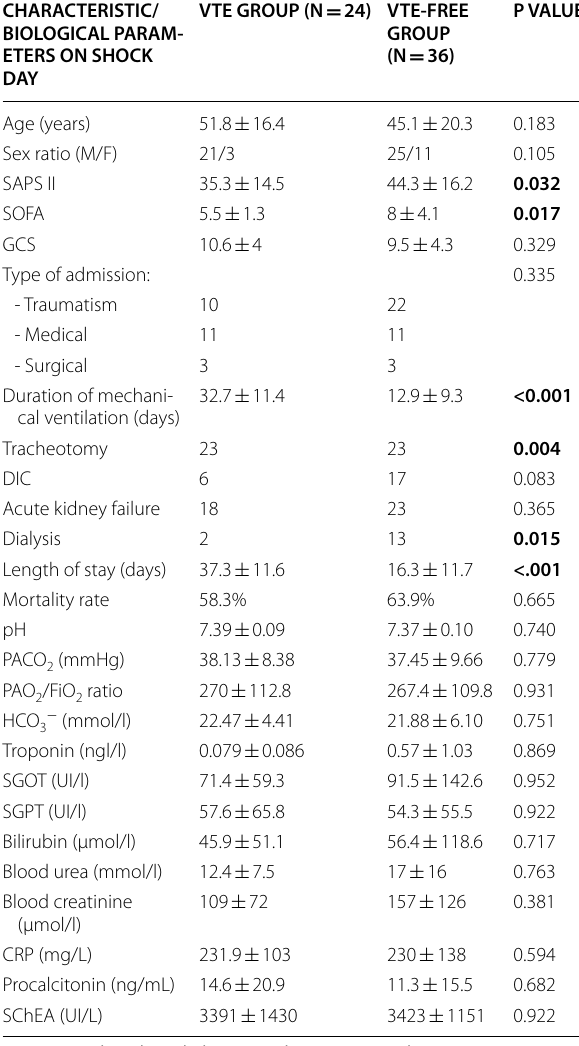
SOFA score: Sepsis-related Organ Failure Assessment score; SGOT: Sérum Glutamooxaloacétate Transférase; SGPT: Sérum Glutamopyruvate Transférase; SChEA: Serum Cholinesterase Activity